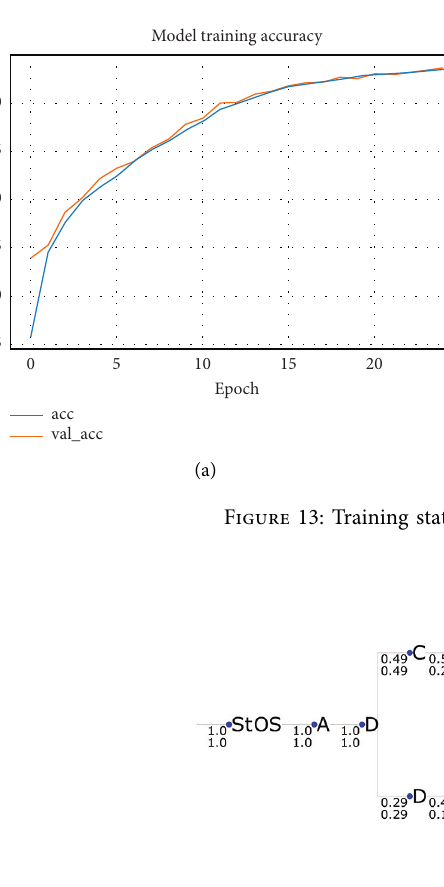
Figure 14: Output of the seq2probTree method for the tree-based system with input sequence [A